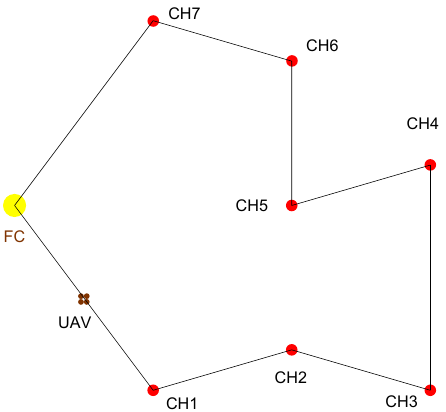
Figure A3. The whole multi-robot system consists of a fusion center (FC) where the UAV starts its route and 7 cluster head (CH) robots around FC. The red circles show the locations of the cluster head (CH) robots in their robot cluster. The UAV uses an optimal strategy such that it visits CH 1, CH 2, CH 3, CH 4, CH 5, CH 6, and CH 7 in order (The path has a length of 244 m). With respect to the initial position at ξ 0 = ( 0,0 ) , the positions of the CH robots are ( ξ 1 , ξ 2 , ξ 3 , ξ 4 , ξ 5 , ξ 6 , ξ 7 ) = (( 24, − 32 ) , ( 48, − 25 ) , ( 72, − 32 ) , ( 72,7 ) , ( 48,0 ) , ( 48,25 ) , ( 24,32 )) m